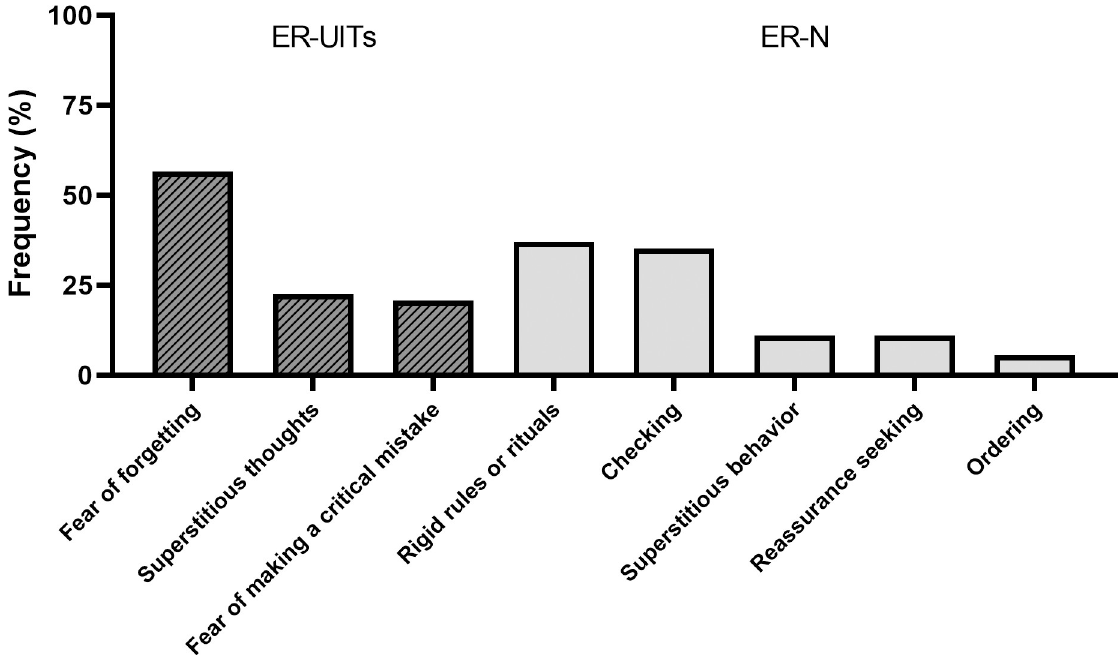
Fig 1. Frequencies (as percentages) of the most frequent exam-related unwanted intrusive thoughts (ER-UITs) and exam-related neutralizing behaviors (ER-N) as reported by the participants on the stress-related thoughts and behavior list at baseline. The frequency represents the number of each reported UIT and behavior within the total number reported (for ER-UITs: n = 53; for ER-N: n = 54) by the participants. Each participant could report a maximum of two UITs as well as two